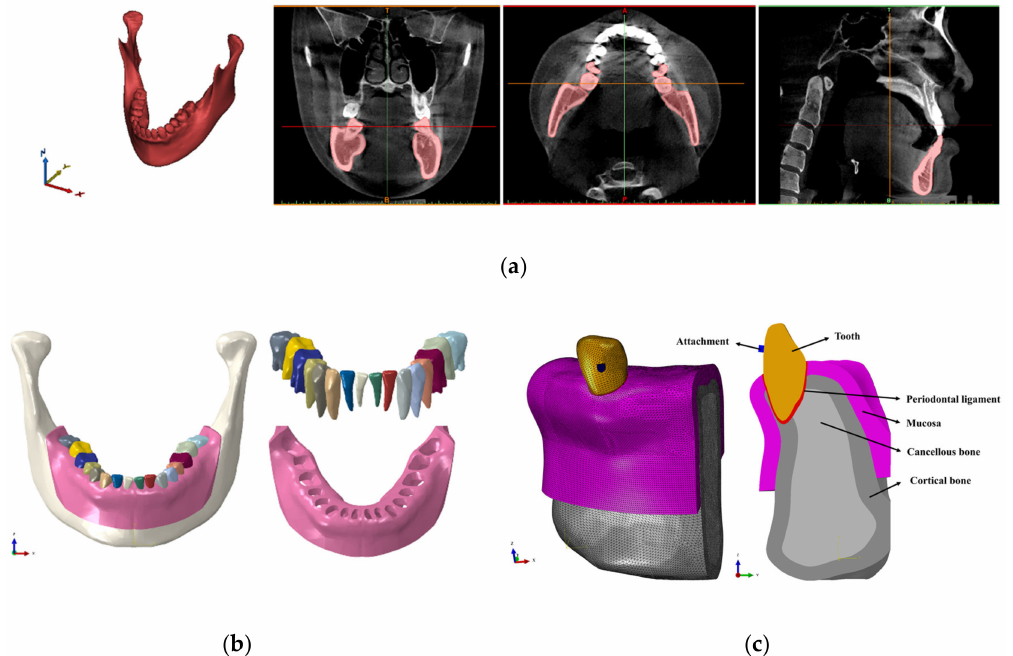
Figure 5. The process of building a 3D mandibular finite element model that includes the teeth, mucosa, PDL, cortical bone, cancellous bone and attachments and the cross-sectional view of the mandibular canine orthodontic treatment model. ( a ) Mandibular reconstruction process through 3D CBCT; ( b ) Building cortical bone, cancellous bone, mucosa and teeth models; and ( c ) Building orthodontic treatment model with attachments in